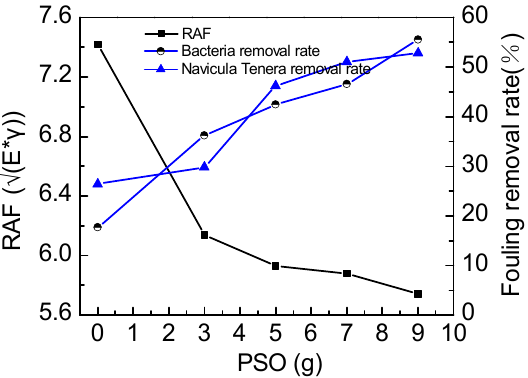
Figure 10. The influence of the addition amount of PSO on relative adhesion factor (RAF) and removal rate.